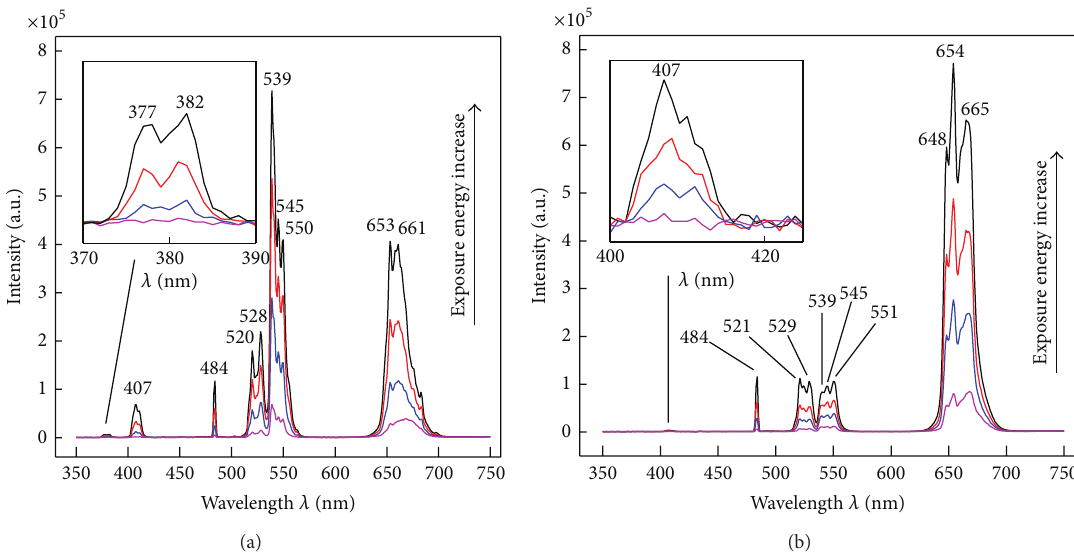
Figure 7: PL spectra of (a) Er 3+ and (b) Er 3+ /Yb 3+ codoped nanocrystals when exposed to 980nm laser.